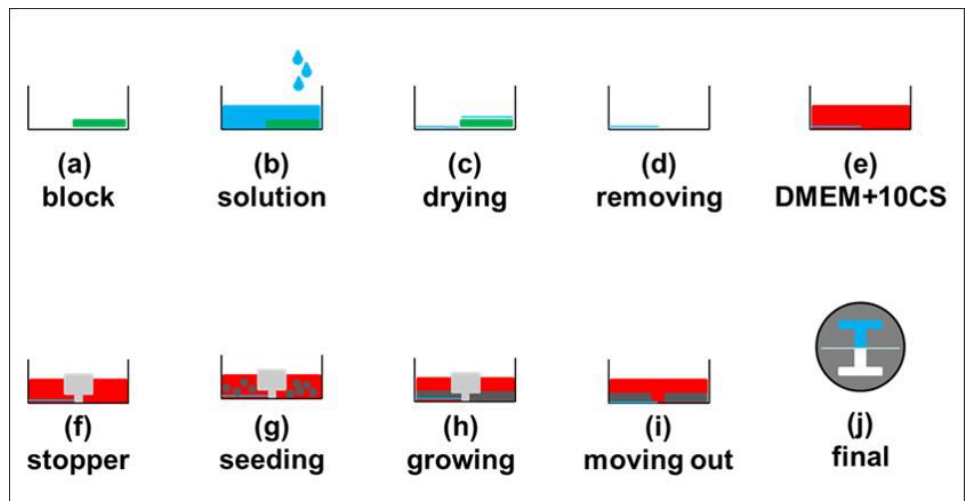
Figure 2. Experimental procedure. ( a )–( i ) Side view of the dish. ( a ) Block half of the dish with the tape. ( b ) Pour in the solution. ( c ) Wait until dried. ( d ) Remove the tape. ( e ) Add in the culture medium. ( f ) Place the stopper in the middle of the dish. ( g ) Seed in cells. ( h ) Wait until a cell monolayer was formed. ( i ) Remove the stopper. ( j ) Top view of the dish. Green: tape. Blue: washing buffer (PBS). Red: Cell medium (DMEM + 10% CS). Light gray: stopper. Dark gray: cell.